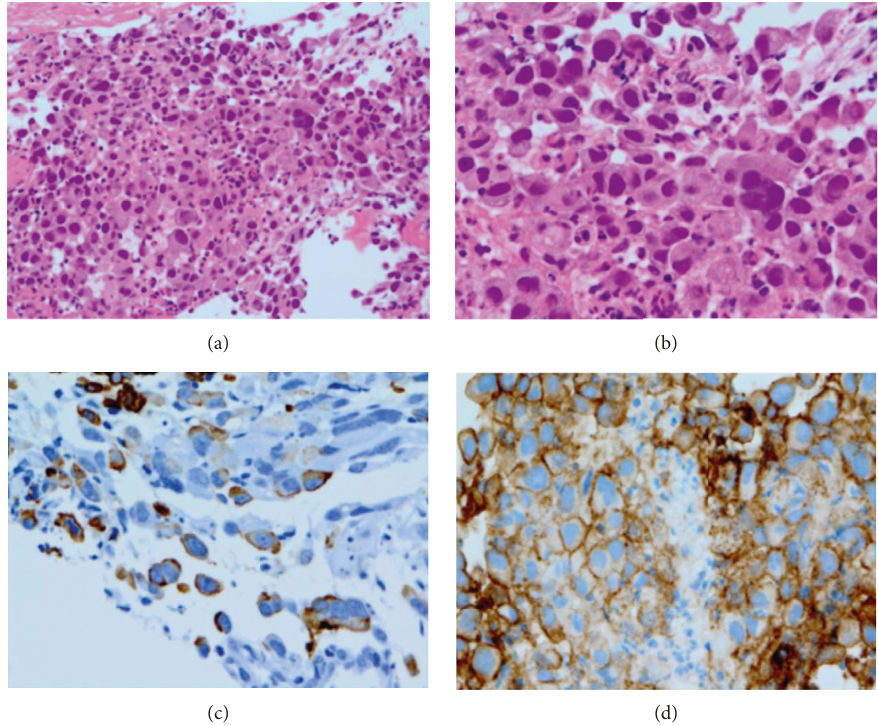
Figure 2: Histological examination of a lung biopsy specimen at low (a) and high (b) magnifications, showing pleomorphic giant tumor cells with poor cohesiveness. No apparent differentiation toward adenocarcinoma, squamous cell carcinoma, or neuroendocrine carcinoma was seen. Immunostaining showed that the tumor cells were positive for expression of CAM5.2 (c) and PD-L1